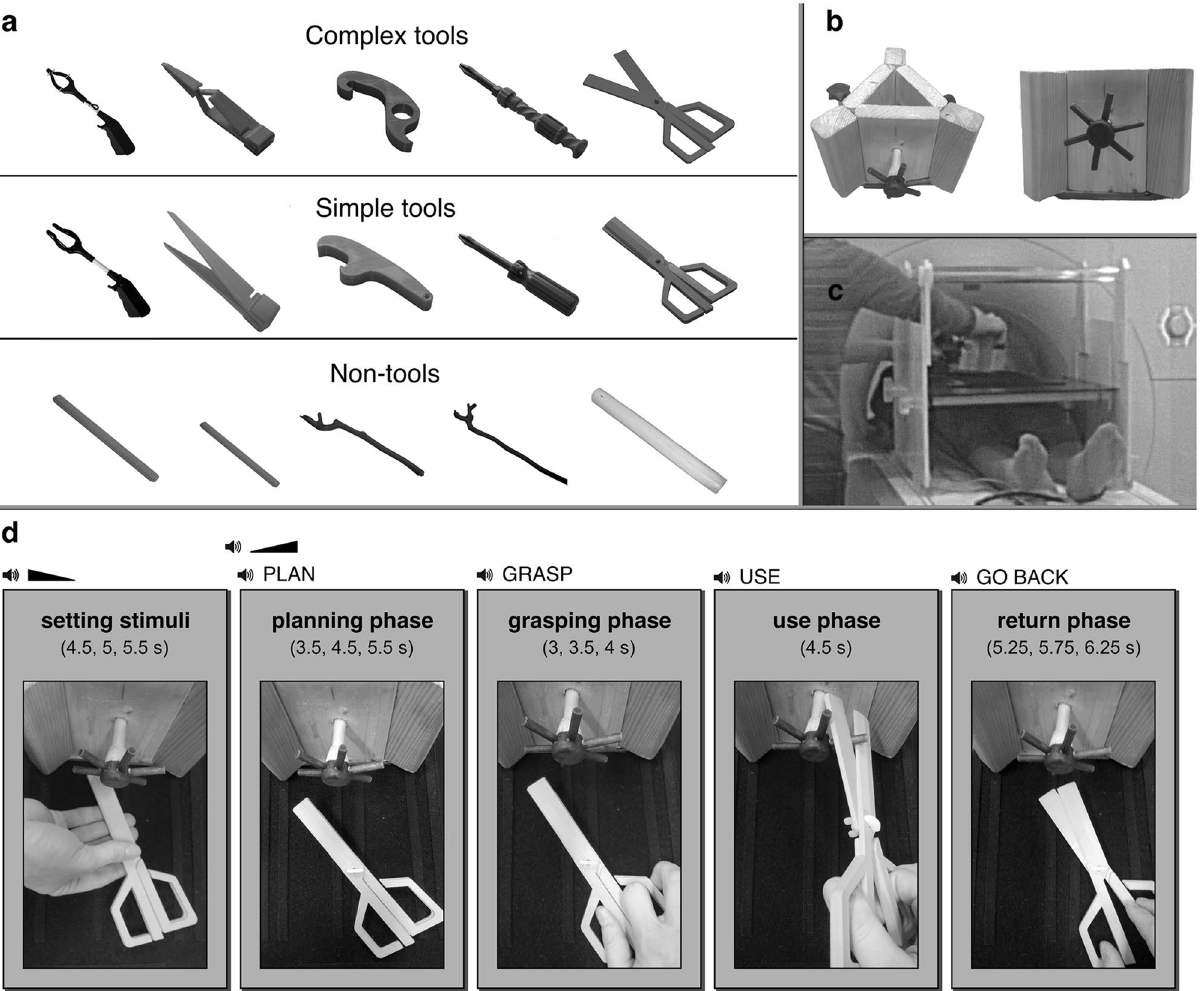
Figure 1. Stimuli, apparatus and study design. ( a ) Examples of stimuli. Two sets of complex, and simple tools in two different sizes, as well as one set of control objects was utilized. ( b ) Action recipients. We devised three recipient objects to be acted on by all stimulus kinds. ( c ) Stimuli and action recipients were positioned on the apparatus table by an experimenter before trial onset. ( d ) Trial structure and timing of tasks in main experiments. We used an event-related design in which different events had variable durations, as depicted within each frame at the bottom of this figure. Participants could view the workspace only in time intervals indicated by the auditory cue. Eyes were always closed during stimulus set up